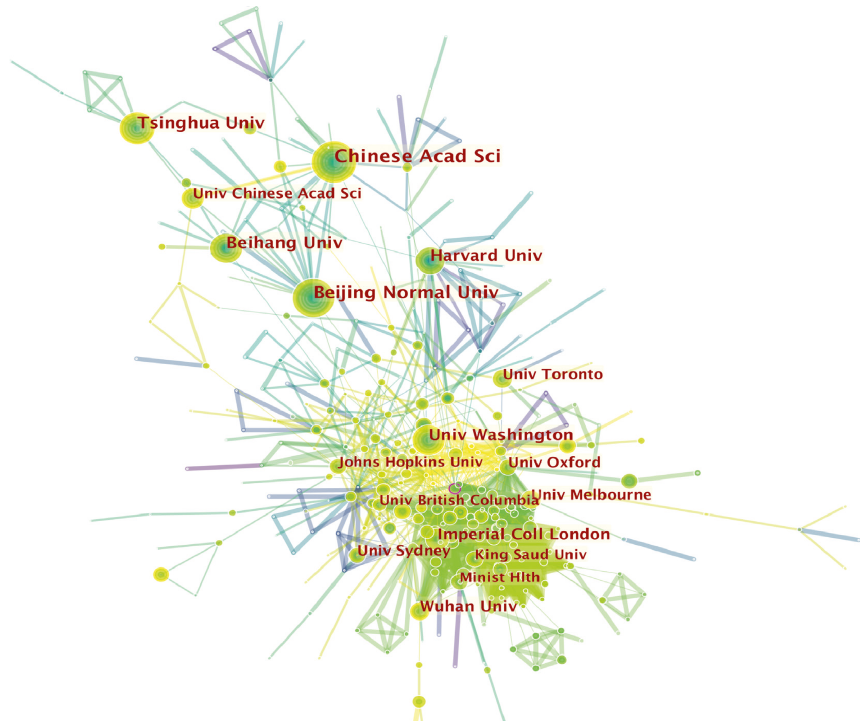
Figure 4: Institutions’ cooperation network of international DEM